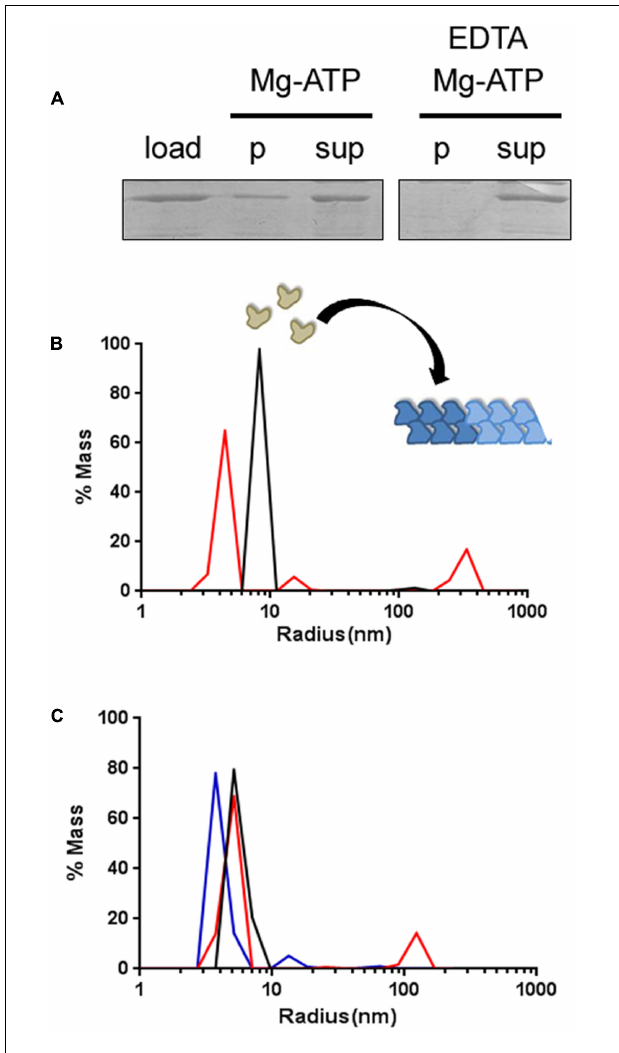
FIGURE 2 | GFP-AlpC forms large polymeric assemblies following ATP incubation. (A) Sedimentation assay reveals the polymerization of GFP-AlpC after ATP incubation. One micromolar AlpC was incubated with Mg 2 + and ATP (1 mM). After centrifugation a substantial part of AlpC sediments due to polymer formation. Polymerization is Mg-ATP dependent, since addition of EDTA prohibits AlpC sedimentation (p, pellet fraction; sup, supernatant; load, total protein). (B) Using dynamic light scattering, ATP induced GFP-AlpC filament formation was observed. In absence of ATP a single protein species is detected indicating primarily monomeric/dimeric species (black line). Incubation with ATP results in the detection of peaks with increased radii demonstrating the formation of a larger protein species (red line). (C) Addition of free mCherry-AlpA in equimolar concentrations to AlpC results in GFP-AlpC de-polymerization (blue line), giving similar hydrodynamic radii as found when GFP-AlpC was incubated without ATP (black line). Polymerization of GFP-AlpC in presence of ATP is depicted by a red